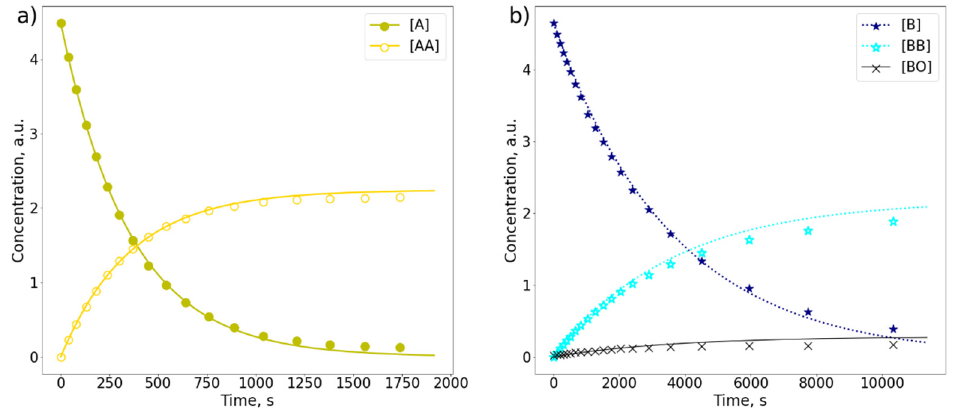
Figure 2. The comparison of photodimerization curves ( λ = 365 nm) derived from 400 MHz 1 H-NMR spectra of ( a ) anthracene ( A ) and ( b ) 9-bromoanthracene ( B ) in separate samples each of 4.5 mM concentration in CD 2 Cl 2 . Two products are observed: a dimer of A ( AA ) and a dimer of B ( BB ).